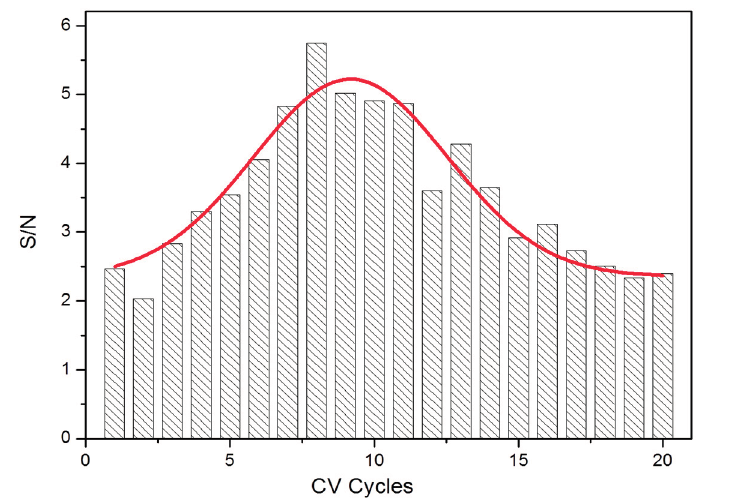
Figure 2. Signal-to-noise (S/N) statistics of current response to 2 µM